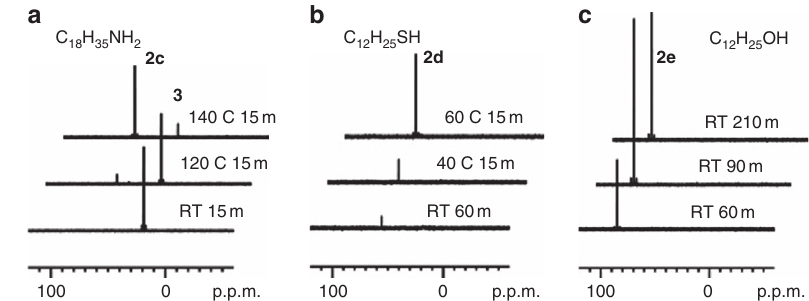
Figure 5 | 31 P NMR spectra of reaction mixtures of 3 þ 6Cd(OA) 2 þ HY. ( a ) 16RNH 2 . ( b ) 4RSH. ( c ) 16ROH. The slowest disappearance of 3 occurs with the use of amine, the trend of which is in agreement with that shown in Fig. 1. The relevant pathway to the formation of monomers and 2 is shown in Supplementary Fig. 25.